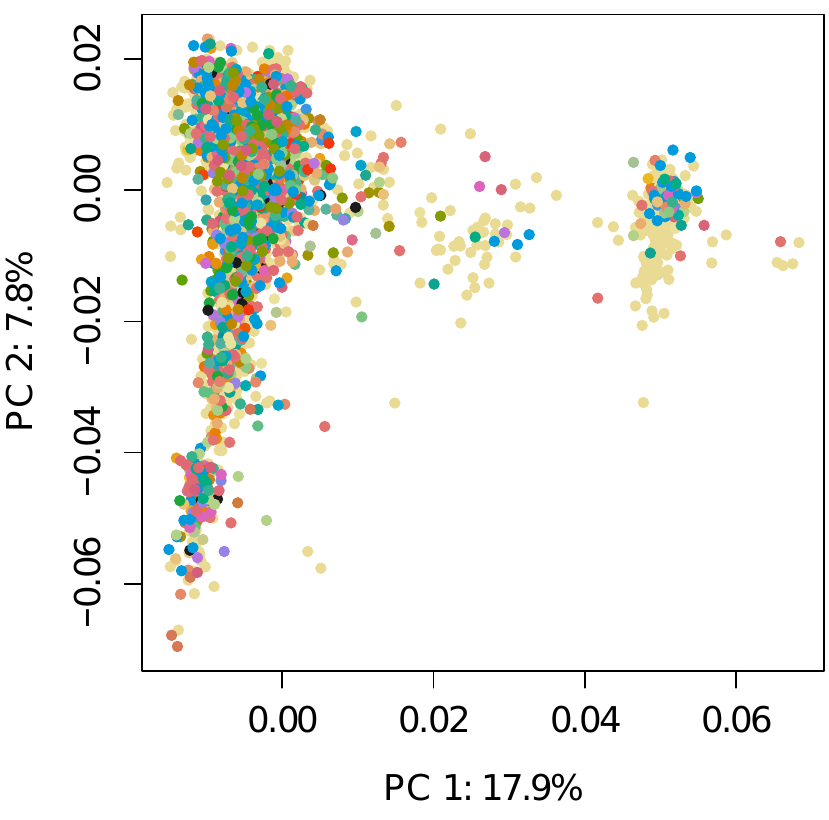
Figure 2. Principal components analysis of the population based on the genomic relationship matrix ( 𝑮 ). The different colors indicate the 124 farms on which each individual was located.